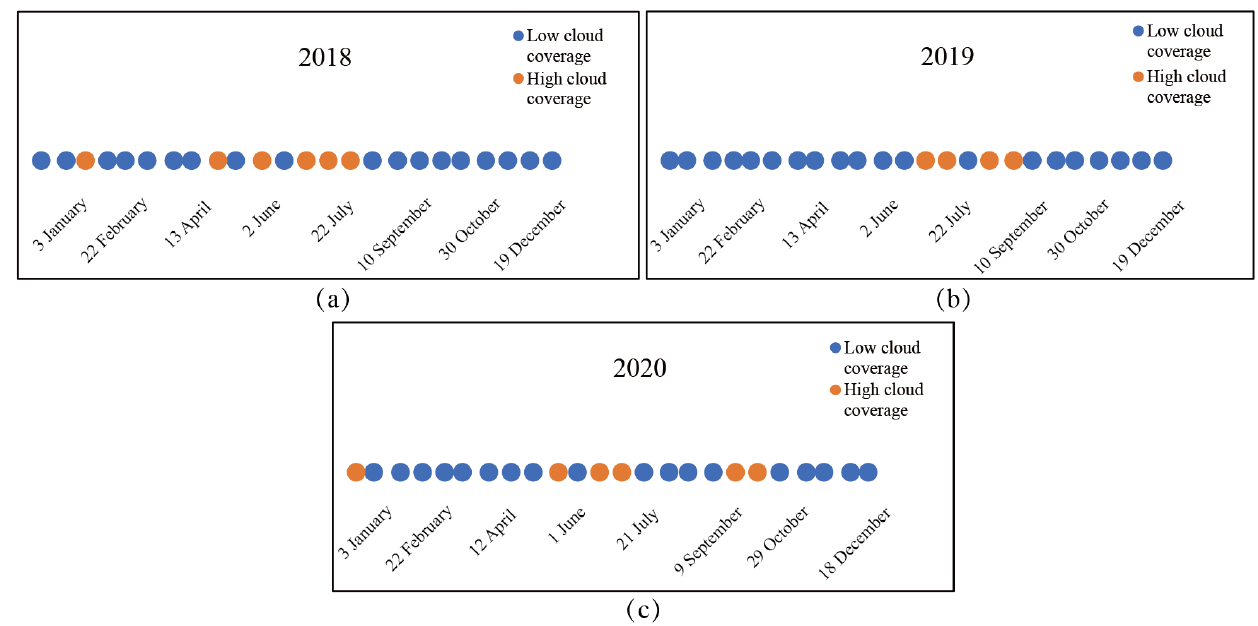
Figure 2. The cloud distribution of Sentinel-2 images in the study area; ( a – c ) represent the dates of cloud coverage status in 2018, 2019, and 2020, respectively. The blue dots indicate the dates when images had low cloud coverage, and the orange dots show the date images with high cloud coverage.